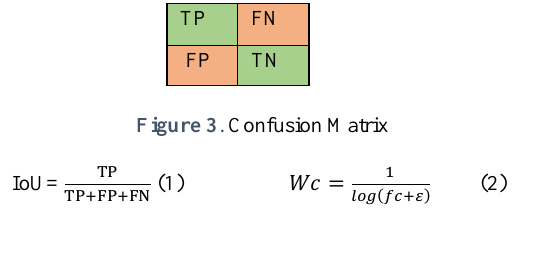
Figure 3 . Confusion Matrix